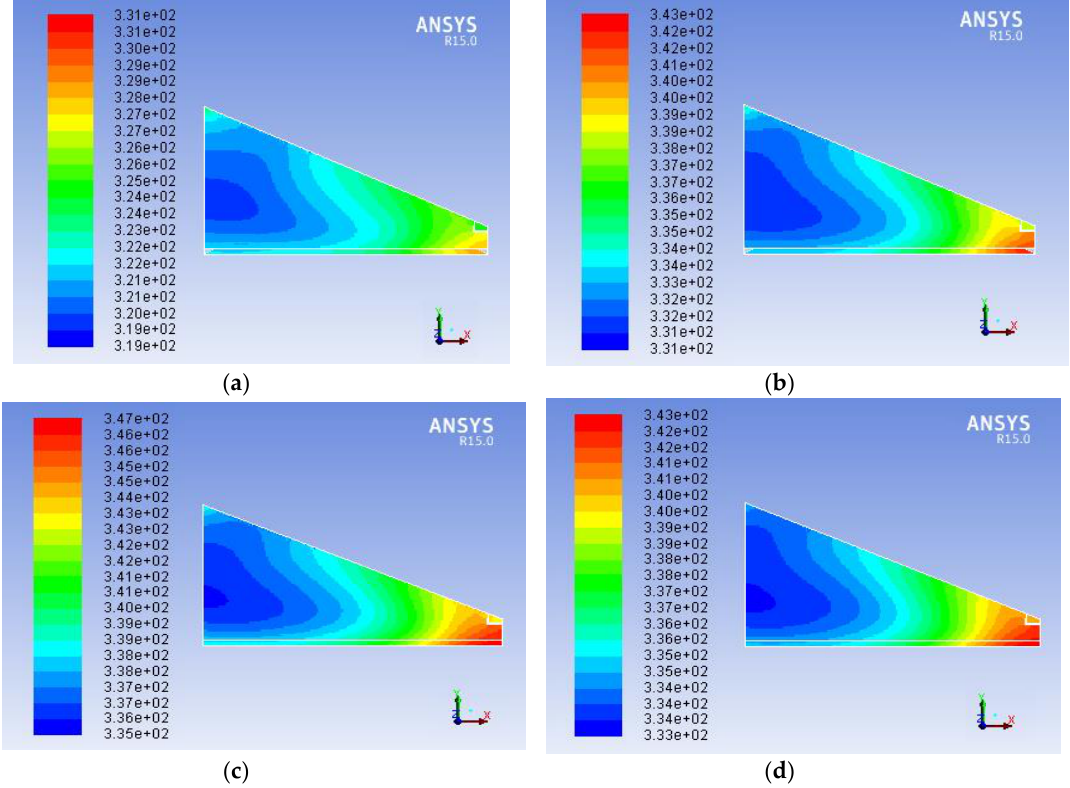
Figure 9. T he temperature contours of the internal mixture at X-Y plane at different times with a water depth of 2 cm. ( a ) Contour of temperature at 10:00, ( b ) contour of temperature at 12:00, ( c ) contour of temperature at 14:00, ( d ) contour of temperature at 16:00.